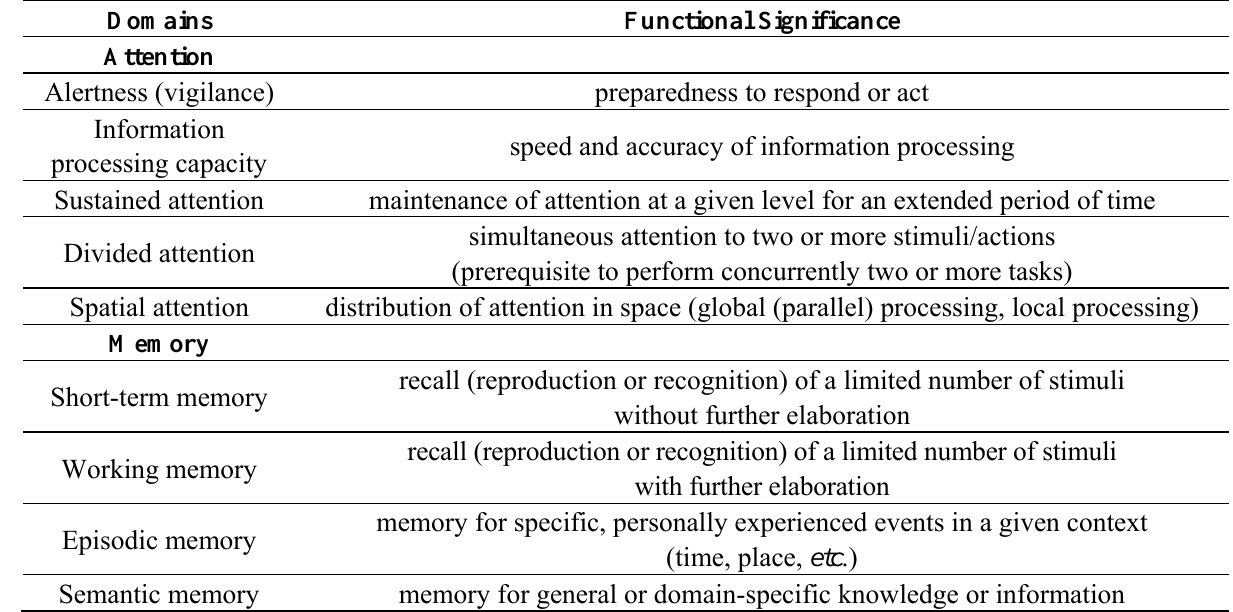
Table 1. Mental domains and functional